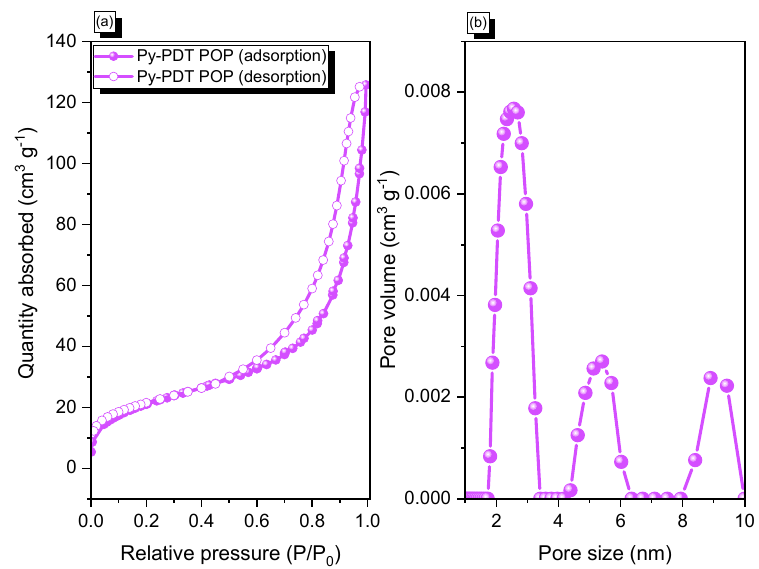
Figure 2. N 2 adsorption/desorption ( a ) and pore size (PSD) curves ( b ) of Py-PDT POP. Moreover, we examined the morphology of Py-PDT POP using high-resolution transmission electron microscopy (HR-TEM) and field emission scanning electron microscopy (FE-SEM). Py-PDT POP contained aggregated particles with pores, based on the FE- SEM imaging (Figure 3a–c). SEM-EDS (energy-dispersive X-ray scattering) was used to confirm the compositions and different elements in the chemical structures of Py-PDT POP. Figure 3d–g show evidence of carbon, nitrogen, and oxygen atoms distributed in the Py-PDT POP skeleton. The HR-TEM images (Figure 3h,i) showed the existence of bright and alternating dark patches, which likely suggested that Py-PDT POP included porous networks.